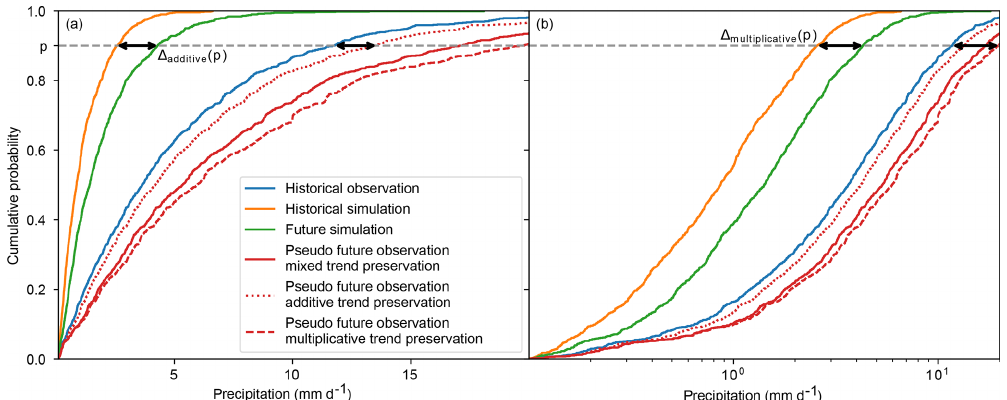
Figure 1. Schematic of climate change signal transfer from simulations to observations for wet-day precipitation. Empirical cumulative distribution functions of historical and future simulations and observations are displayed using a linear precipitation scale in (a) and a logarithmic precipitation scale in (b) . Pseudo future observations generated preserving different kinds of trends are shown in red with different line styles. For the 90th percentile, black double-headed arrows indicate additive trend preservation in (a) and multiplicative trend preservation in (b) . Mixed trend preservation is explained in the text.